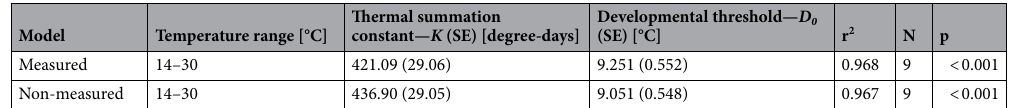
Table 1. Thermal summation models for the total immature development of N. littoralis , calculated using measured or non-measured specimens.